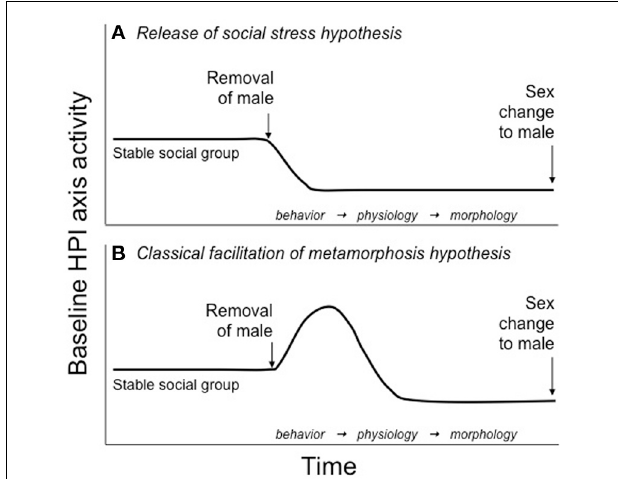
FIGURE 1 | Hypotheses for HPI axis involvement in teleost sex change. (A) The release of social stress hypotheses, originally put forth by Perry and Grober (2003), suggests that baseline HPI axis activity is maintained at relatively constant, elevated levels in females of protogynous species because of the stress of subordination imposed by the dominant male. After male removal from the social group, HPI axis activity decreases in the most dominant female as she is released from the social stress of subordination. It is this decrease in HPI activity that allows for the initiation of sex change. Lower ranking females do not change sex because the dominant female/sex-changer maintains their subordinate status and, subsequently, their elevated baseline HPI axis activity. (B) The classical facilitation of metamorphosis hypothesis, discussed here for the first time, suggests that following male removal, baseline HPI axis activity increases in the dominant female/sex changer. Elevated HPI axis activity could be used to fuel the energetically costly changes in behavior, physiology, and morphology that occur during sex change and/or activate the thyroid axis, which could regulate cellular differentiation and apoptosis associated with sex change. This hypothesis is consistent with an evolutionarily conserved role for the HPA/I axis in the regulation of life history